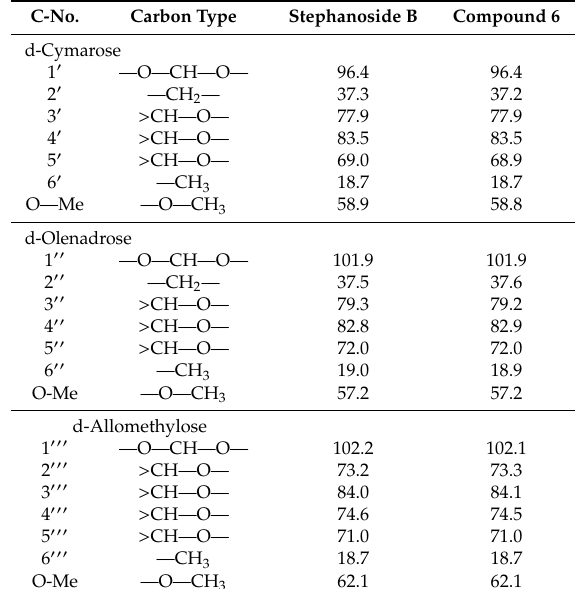
Table 6. The 13 C NMR chemical shifts of sugar chains of stephanoside B and compound 6 ( δ : ppm). C-No.